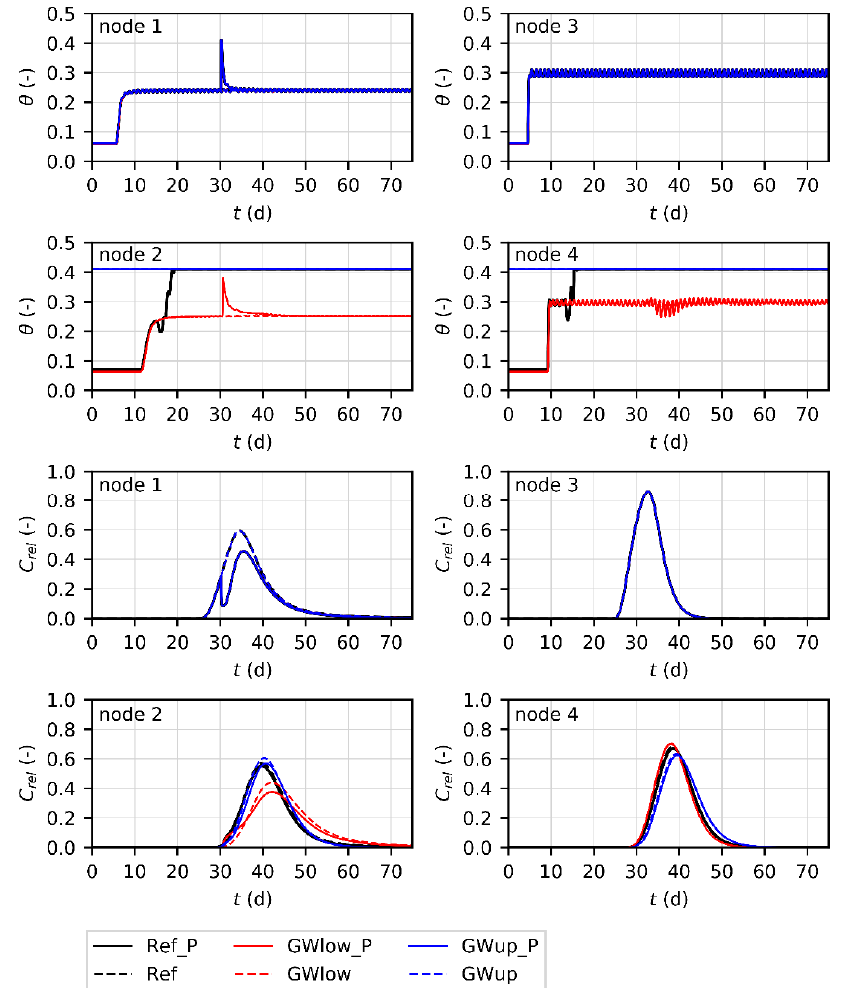
Figure 4. Simulated values of water content θ and relative solute concentration C rel at four selected observation nodes (as depicted in Figures 2 and 3) for the reference scenario and the scenarios GWup and GWlow (groundwater table increased/reduced by 1 m). _P indicates the scenarios with a precipitation event.